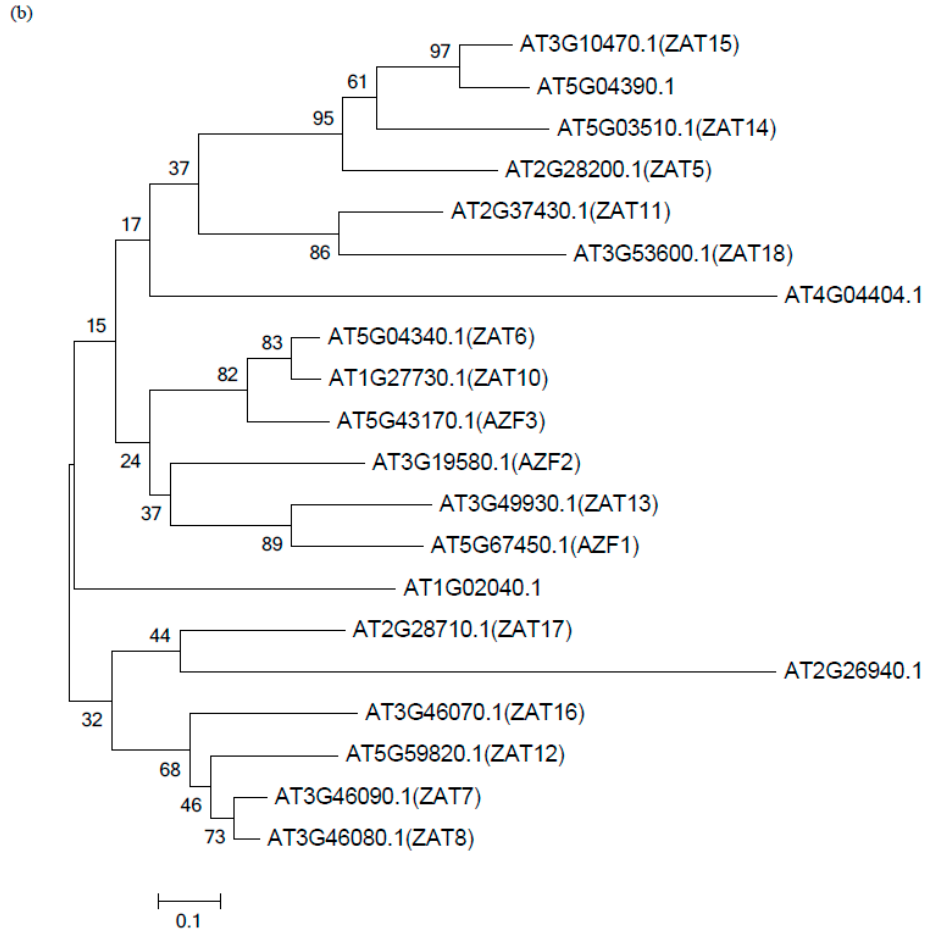
Figure 2. ( a ). Amino acid sequence comparisons of the two zinc-finger regions and the conserved domain in C1-2i subclass of C2H2-type ZFPs in Arabidopsis . Sequence alignment was performed with ClustalX2. The first zinc-finger domain, second zinc-finger domain, and the ethylene-responsive element binding-factor-associated amphiphilic repression (EAR) domain were highlighted using a black box; ( b ). Phylogenetic tree of members of the C1-2i subclass of Arabidopsis C2H2-type zinc-finger proteins (ZFPs). The phylogenetic tree was constructed using MEGA 5 with neighbor-joining method. The number of bootstrap values was set at 1000 replications. Bootstrap values were provided at each node. The genes of the C1-2i subclass are indicated by their accession numbers, with the corresponding gene names in brackets. AZF: Arabidopsis zinc-finger protein; ZAT: zinc finger of Arabidopsis thaliana.